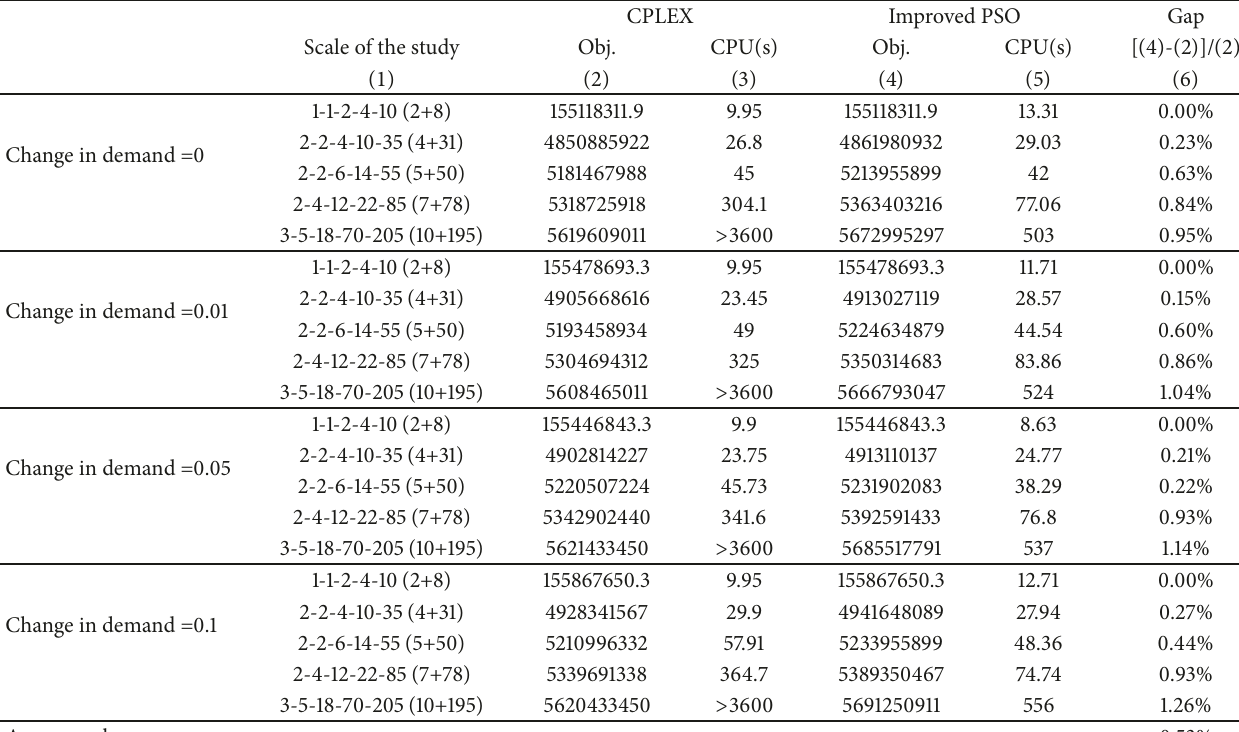
Table 2: Comparison of different kinds of algorithms.